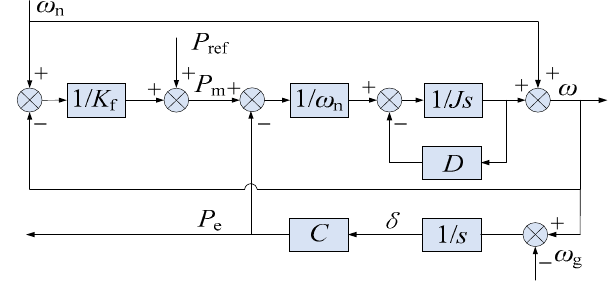
Figure 4. Power control diagram of grid-connected VSG.